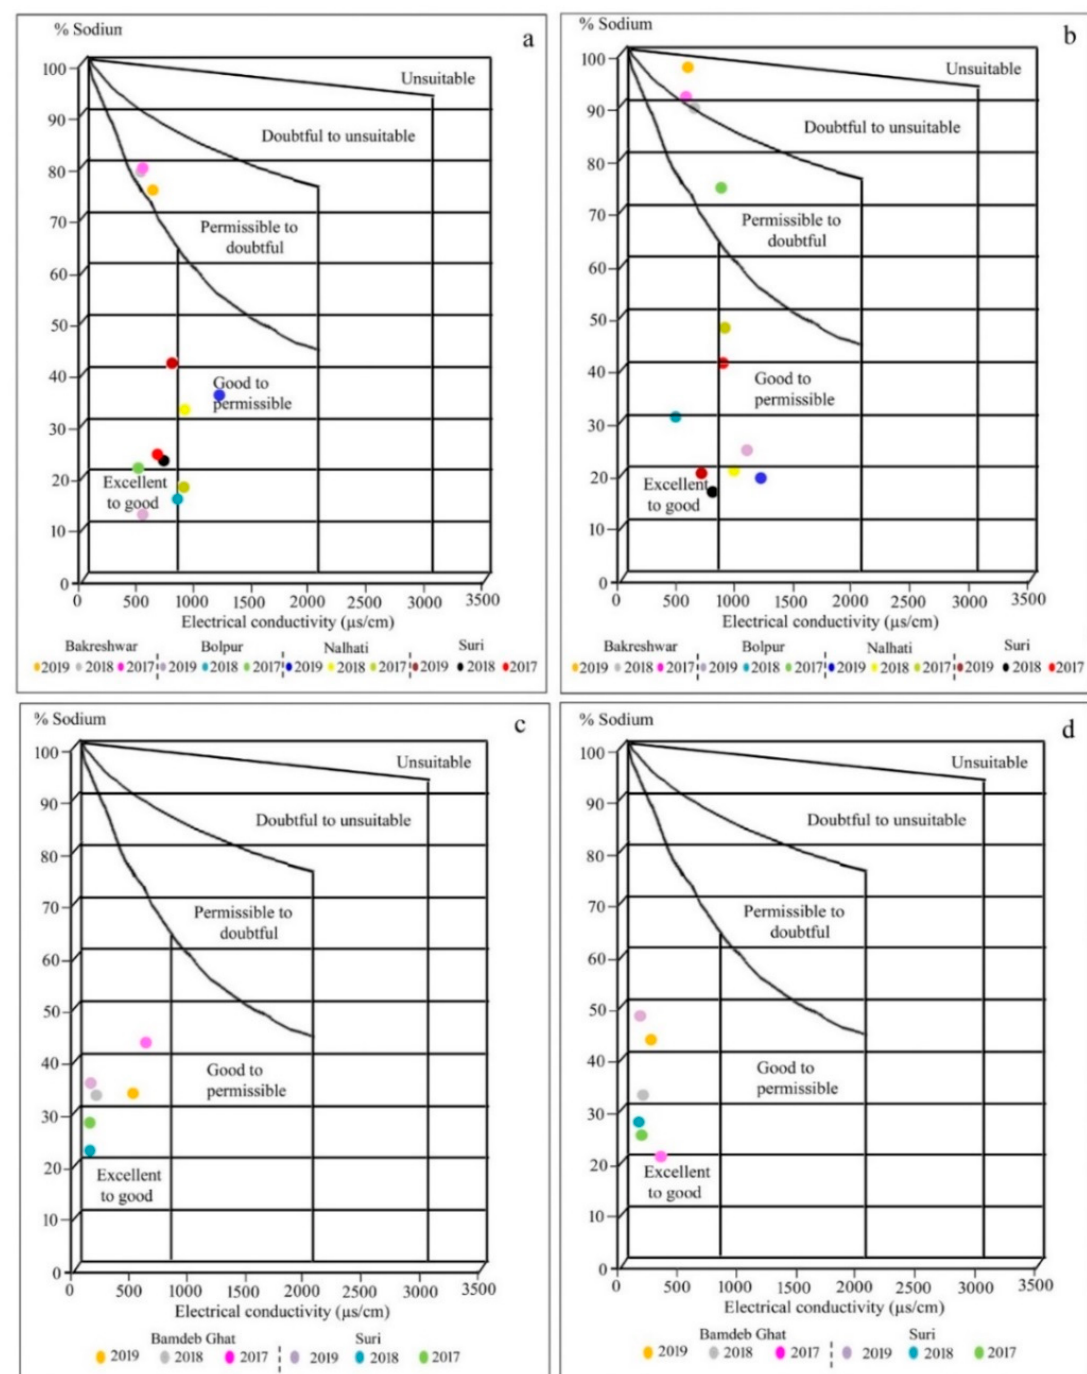
Figure 2. Wilcox diagram representing the suitability of water for irrigation: ( a ) groundwater samples of pre-mon season; ( b ) groundwater samples of post-mon season; ( c ) surface water samples of pre-mon season; ( d ) surface water samples of post-mon season and groundwater in pre- and post-mon periods for irrigation.